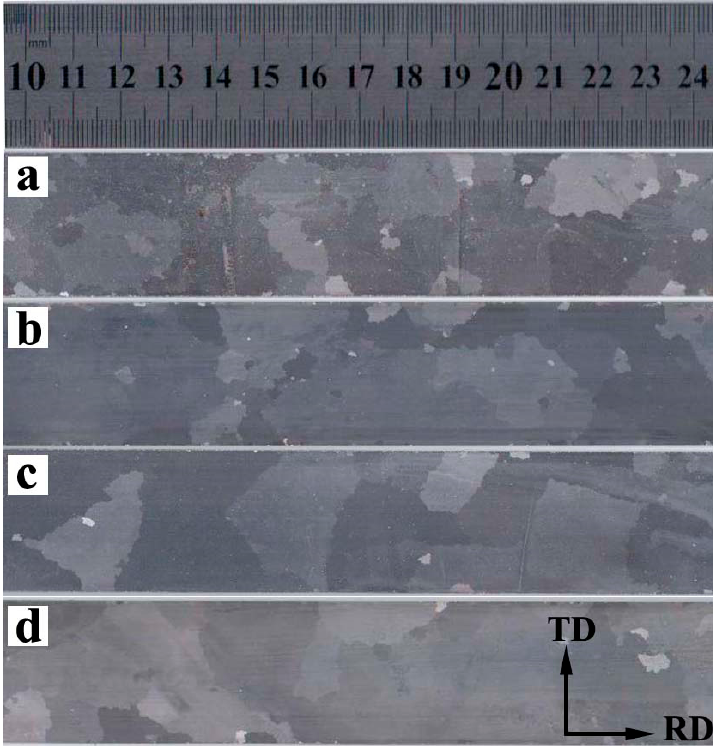
Figure 9. Macrostructure of secondary annealed sheet ( a ) Nb-free, ( b ) Nb-0.005 wt%, ( c ) Nb-0.009 wt% ( d ) Nb-0.025 wt%.